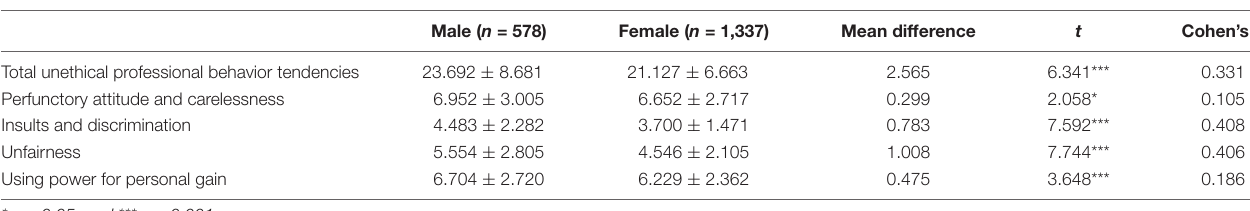
TABLE 5 | Gender differences in student teachers’ unethical professional behavior tendencies.